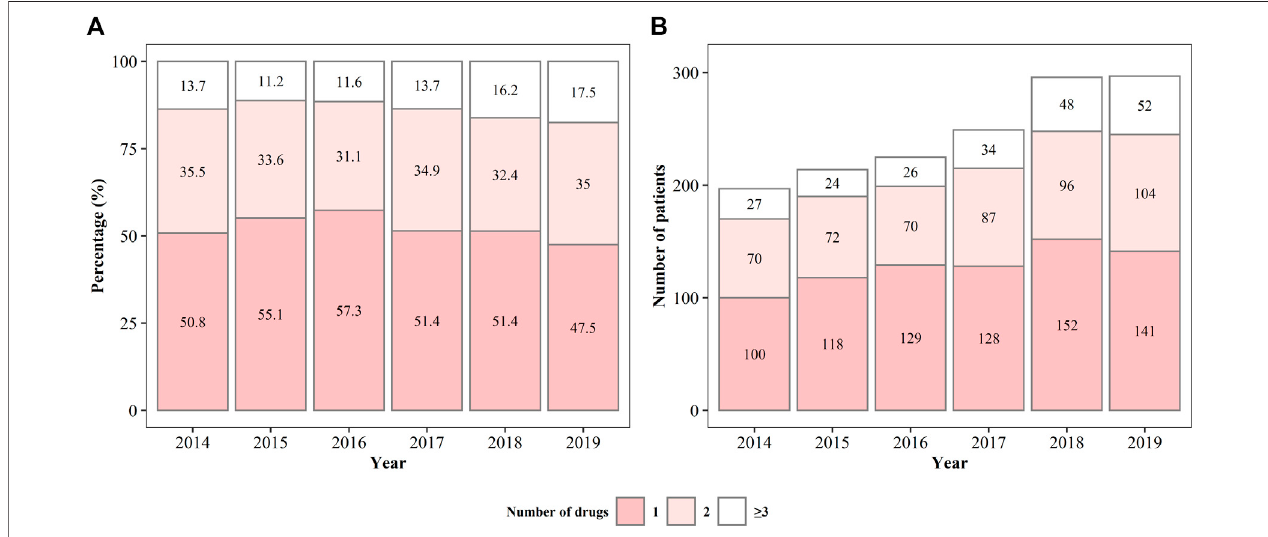
FIGURE 2 | The percentage (A) and number (B) of patients being prescribed different anti-Parkinson ’ s disease drugs from 2014 to 2019.